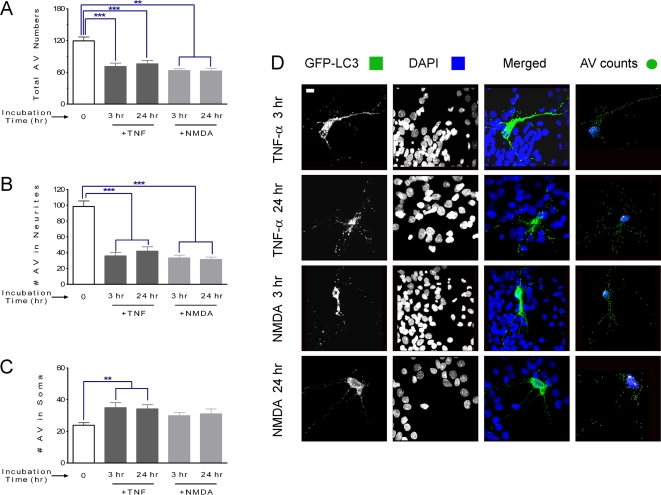
AV counting and distribution for neurons exposed to different treatments.(A) Total AV counting results show that a significant drop occurs in neurons exposed to TNF-α or NMDA for 3 or 24 hr. *** P<0.001, ** P<0.01 for n = 6 experiments. All values are mean±SEM. (B and C) Distribution of AV number in soma and neurites respectively. (B) The number of AV in neurites decreased significantly in neurons exposed to both TNF-α or NMDA for 3 or 24 hr. *** P<0.001, for n = 6 experiments. (C) The AV number in soma is increased in neurons after exposure to TNF-α for 3 or 24 hr, however it remained unaffected in neurons after exposure to NMDA. ** P<0.01 for n = 6 experiments. (D) Flattened images of multi-stack confocal optical slices of neurons transfected with GFP-LC3 (green) to label AV, and DAPI (blue) to label the nucleus. The four panels display a typical sample image of a neuron under 3 hr and 24 hr exposure to TNF-α or NMDA at 25 ng/ml and 35 µM respectively. Scale bar, 20 µm.